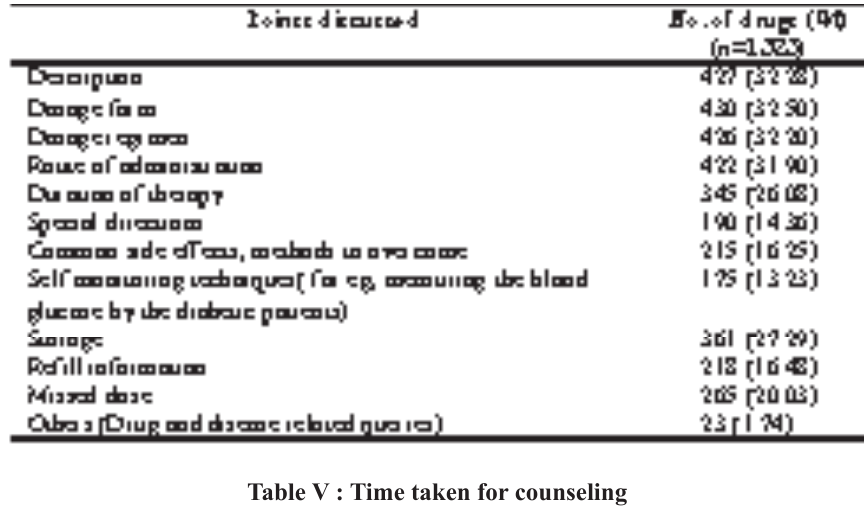
Table IV : Points discussed during counseling